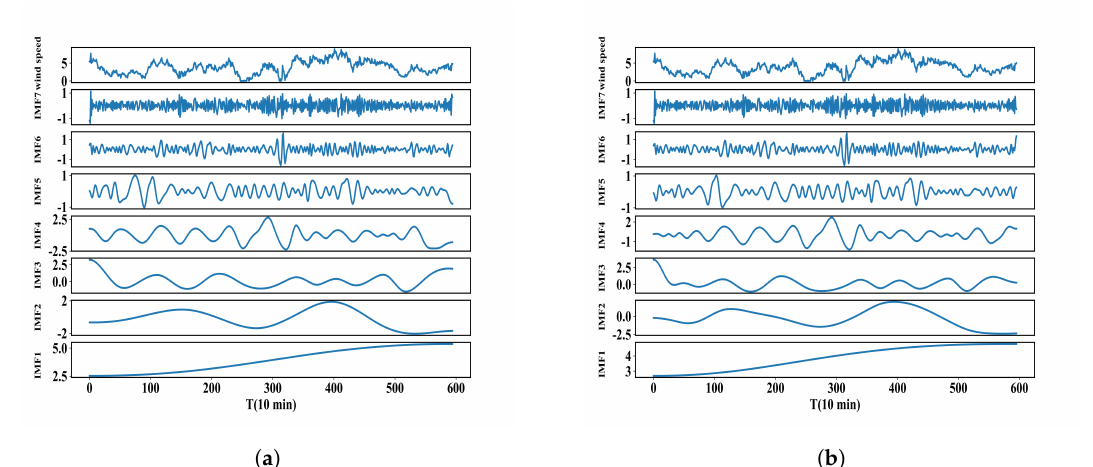
Figure 4. The decomposition results of different wind speed series by the empirical mode decomposition (EMD) algorithm: ( a ) wind speed series 1; ( b ) wind speed series 2.